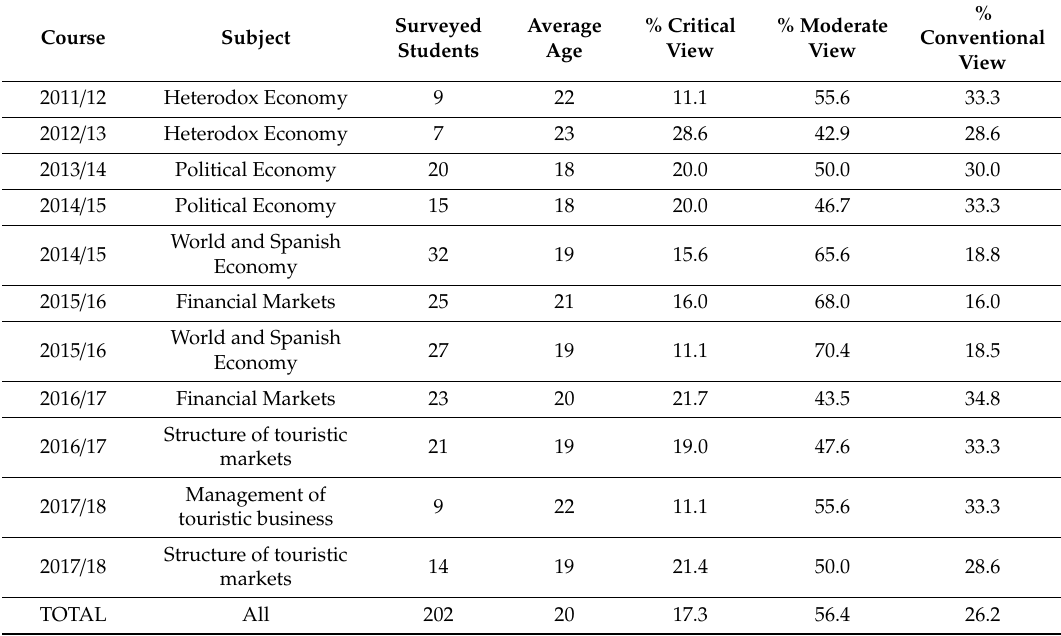
Table 3. Main results of surveyed students according to the “Questionnaire about economic issues”.